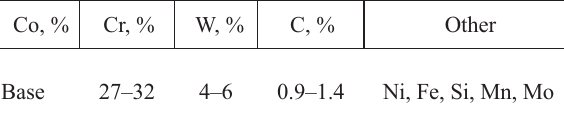
Table 2. Nominal chemical composition of the cladding powder Stellite ® 6 [14]